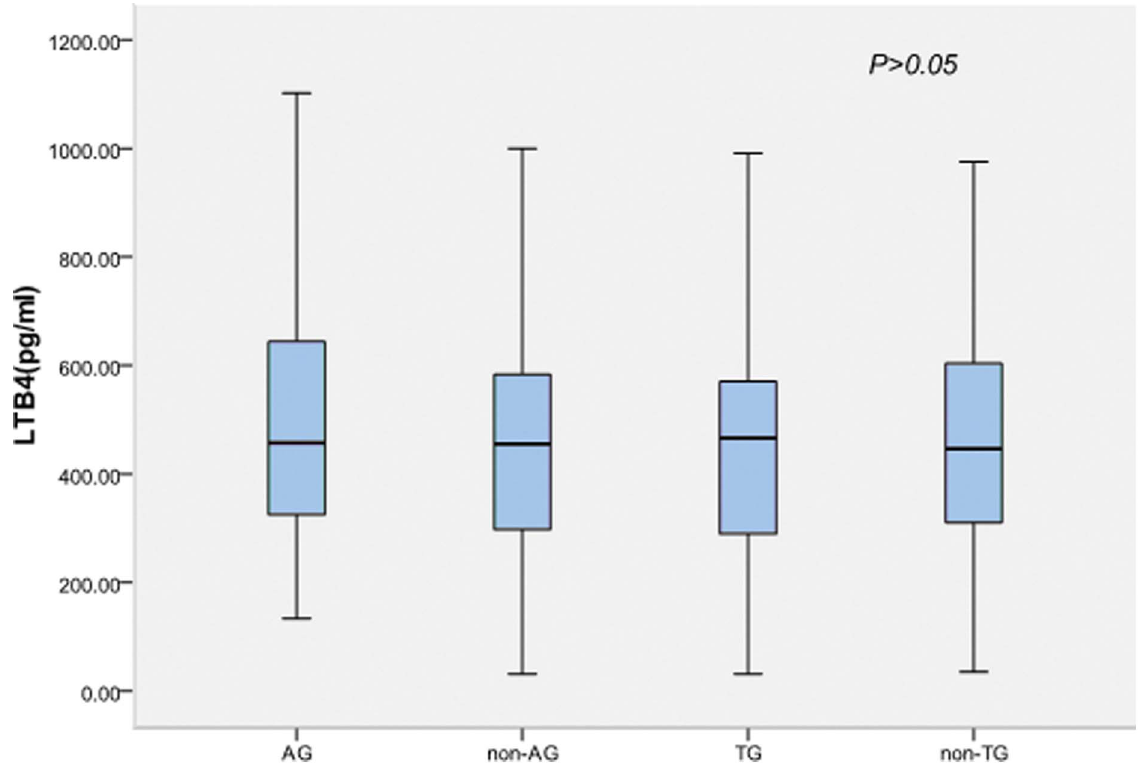
Figure 7. Plot box of serum LTB4 levels (pg/ml) between ALOX5AP haplotypes in ACS patients.